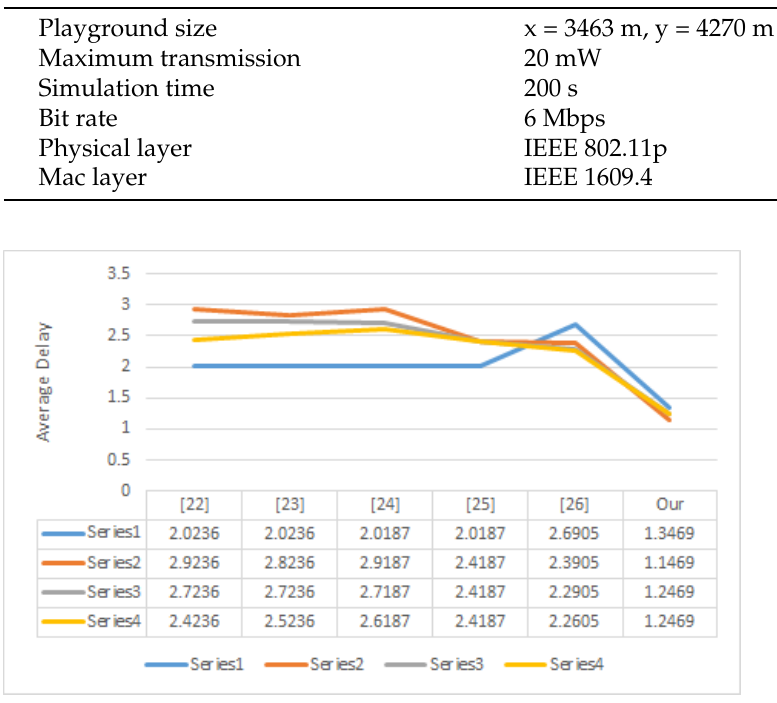
Figure 5. Average Delay for Verifying a Single